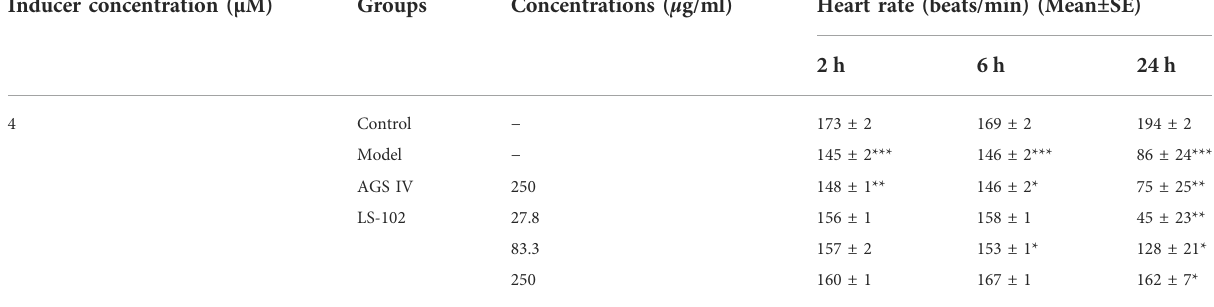
TABLE 4 Quantitative results of LS-102 and AGS IV on heart rate in zebra fi sh after astemizole induction (n = 10). Inducer concentration